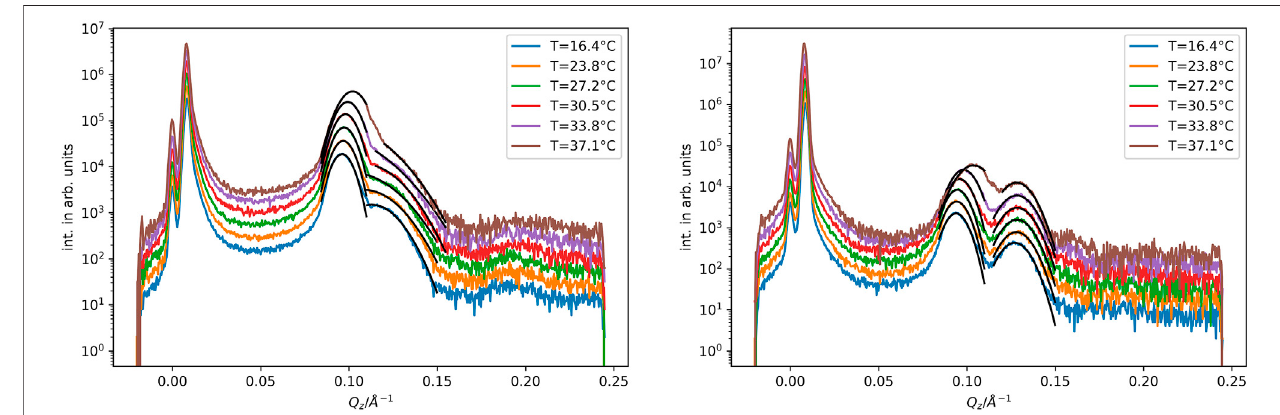
FIGURE8| Verticallinecutsofthe2DGISANS data,takenatQ y (cid:1) 0for1 M (leftpanel) and 2 M (rightpanel) NaClconcentration.BlacklinesareGaussian fi tsto extract peak positions. Curves are shifted along the intensity axis for clarity of the presentation.